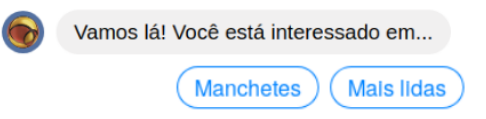
Fig. 19. Poncho chatbot actively offering a feature.